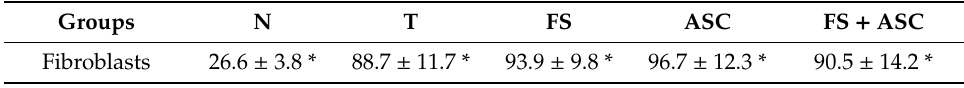
Table 2. Total number of fibroblasts: no di ff erences were observed between the transected tendons. (*) Significant di ff erence between the N group and the transected groups ( n = 3). Groups N T FS ASC FS + ASC Fibroblasts 26.6 ± 3.8 * 88.7 ± 11.7 * 93.9 ± 9.8 * * p <